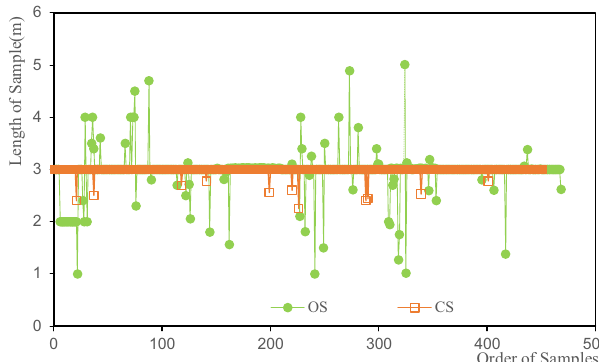
Figure 4. Statistics of the sample length.